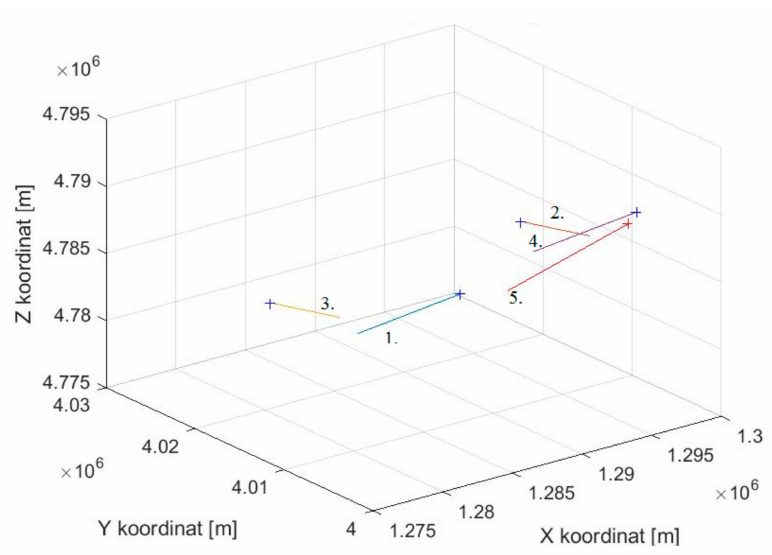
Figure 2. Simulation constellation of users in space.